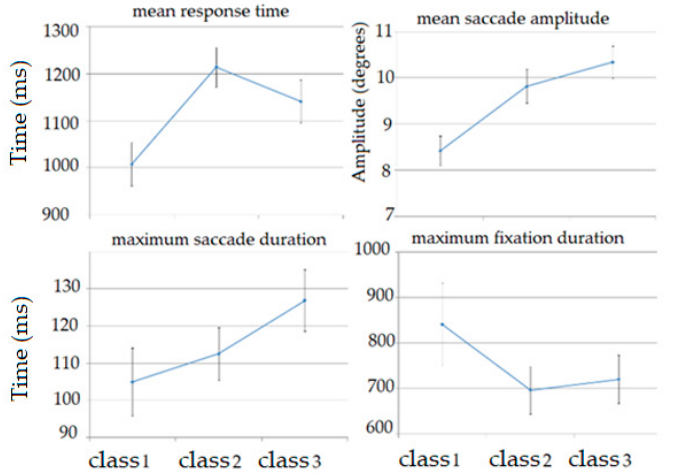
Figure 8. The comparison of mean values from the three-part digit symbol substitution test (DSST) for selected